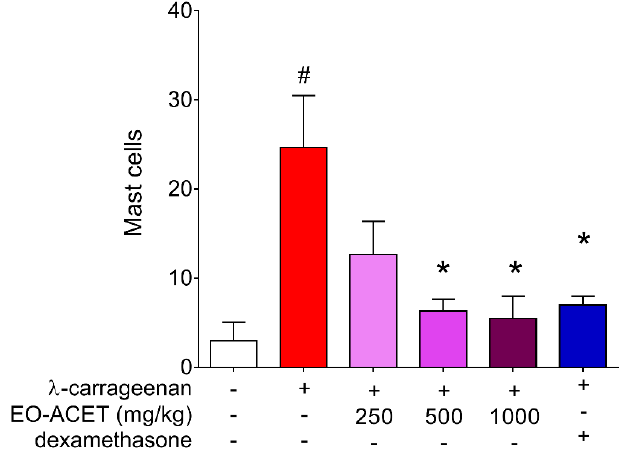
Figure 7. Mast cells counting in BALB/c mice footpad inoculated with of λ -carrageenan and treated with ethyl acetate fraction of Euterpe oleraceae (EO-ACET). Animals inoculated with 25 µL of λ -carrageenan 1% and treated with 100 µL EO-ACET (purple columns) by gavage or with dexa- methasone (blue column) at 5 mg/kg via the intramuscular route. Data represent the mean ± stand- ard deviation of the experiment performed at least in triplicate. # p < 0.001 compared with the group without stimulation or treatment (white column); * p < 0.05, when compared with the stimu- lated and untreated group (red column) after Kruskal–Wallis analysis followed by Dunn’s multi- ple comparisons tests. Table 2. Thickness in millimeters and percentage of λ -carrageenan 1% paw edema inhibition in BALB/c mice treated with ethyl acetate fraction of Euterpe oleraceae . Treatment